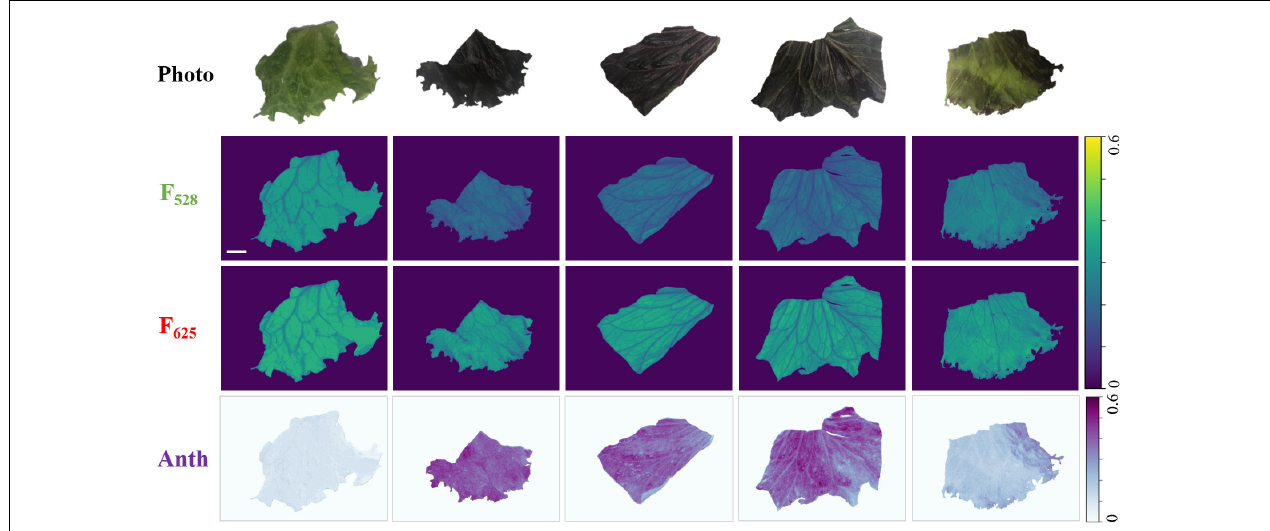
FIGURE 4 | Representative images of the non-invasive anthocyanin measurement of green and red Batavia leaves. First row: the photos of sample leaves as reference. Second row and third rows: fluorescence images excited by 528 and 625 nm. Last row: the images of anthocyanin index (ANTH) which were calculated pixel-wisely from F 528 and F 625 based on Equation 3. The scale bar represents 1 cm.